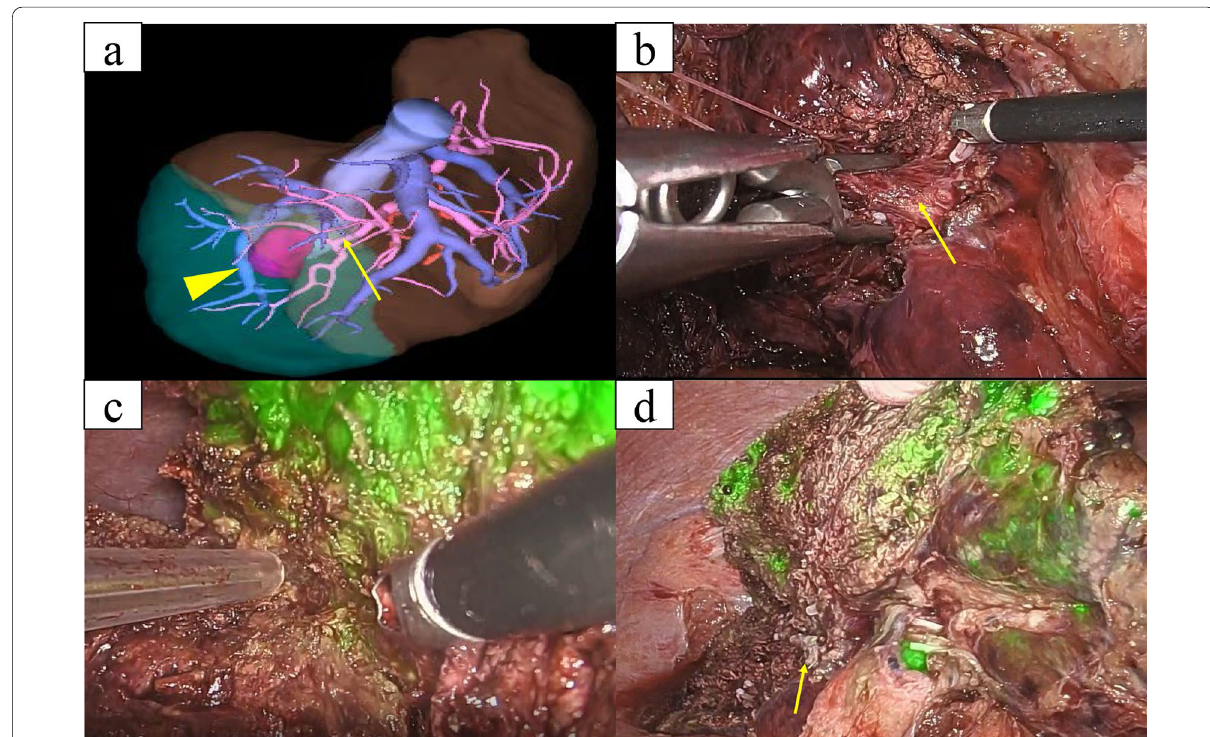
Fig. 2 Intraoperative findings. a Three-dimensional image of hepatectomy simulation. The tumor was found in the hepatic segment 5 of the cranial side of the right hepatic vein (arrowhead). We performed a simulation in which P5 6 (arrow) was scheduled to be resected. b Captured image + after clamping the Glissonean pedicle 5 6 (arrow). c Cut surface of the liver during transection of the liver parenchyma. d Cut surface of the liver + after hepatectomy. The Glissonean pedicle 5 6 (arrow) is collectively resected using the Signia ™ stapling system (Covidien Japan, +